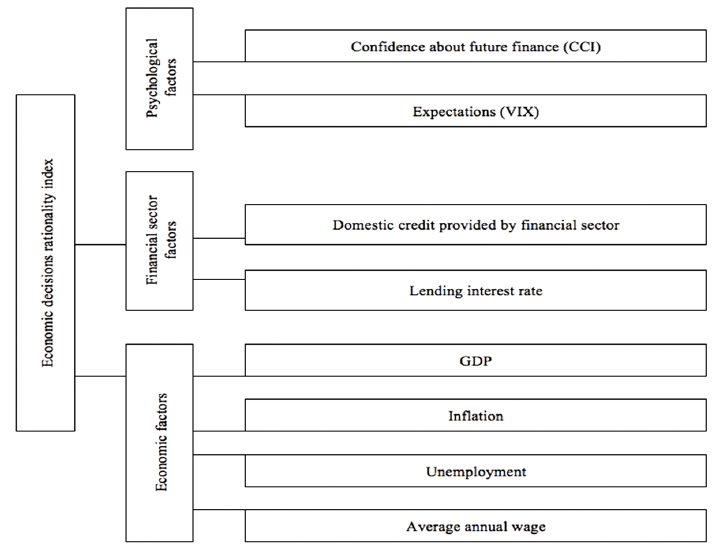
Figure 1. Components of economic decisions rationality index (source: created by